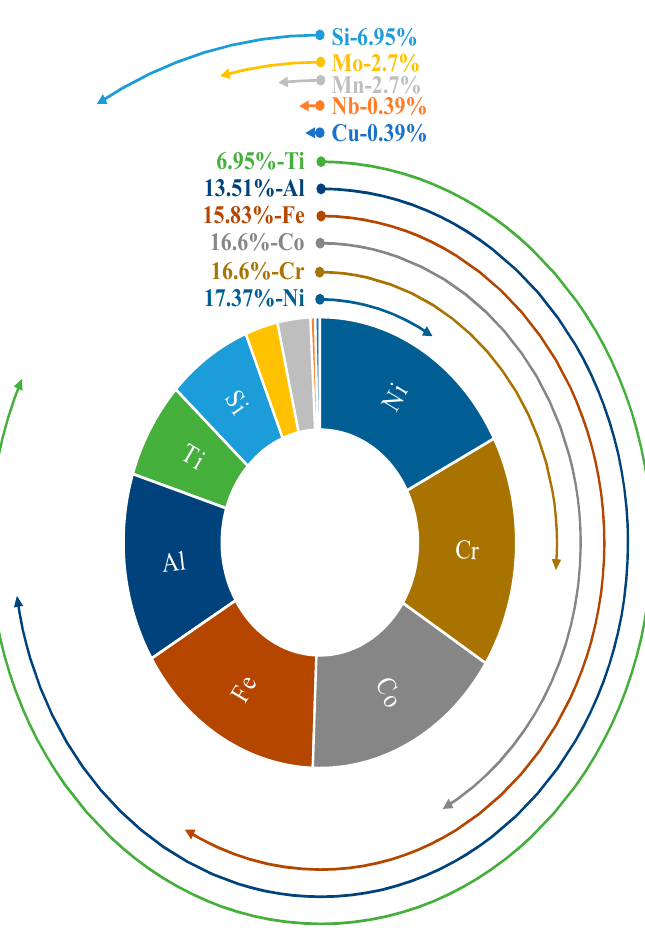
Figure 19. Frequency of use of elements on the periodic table for CCA-based thermal spray coatings as of 2020 [28].